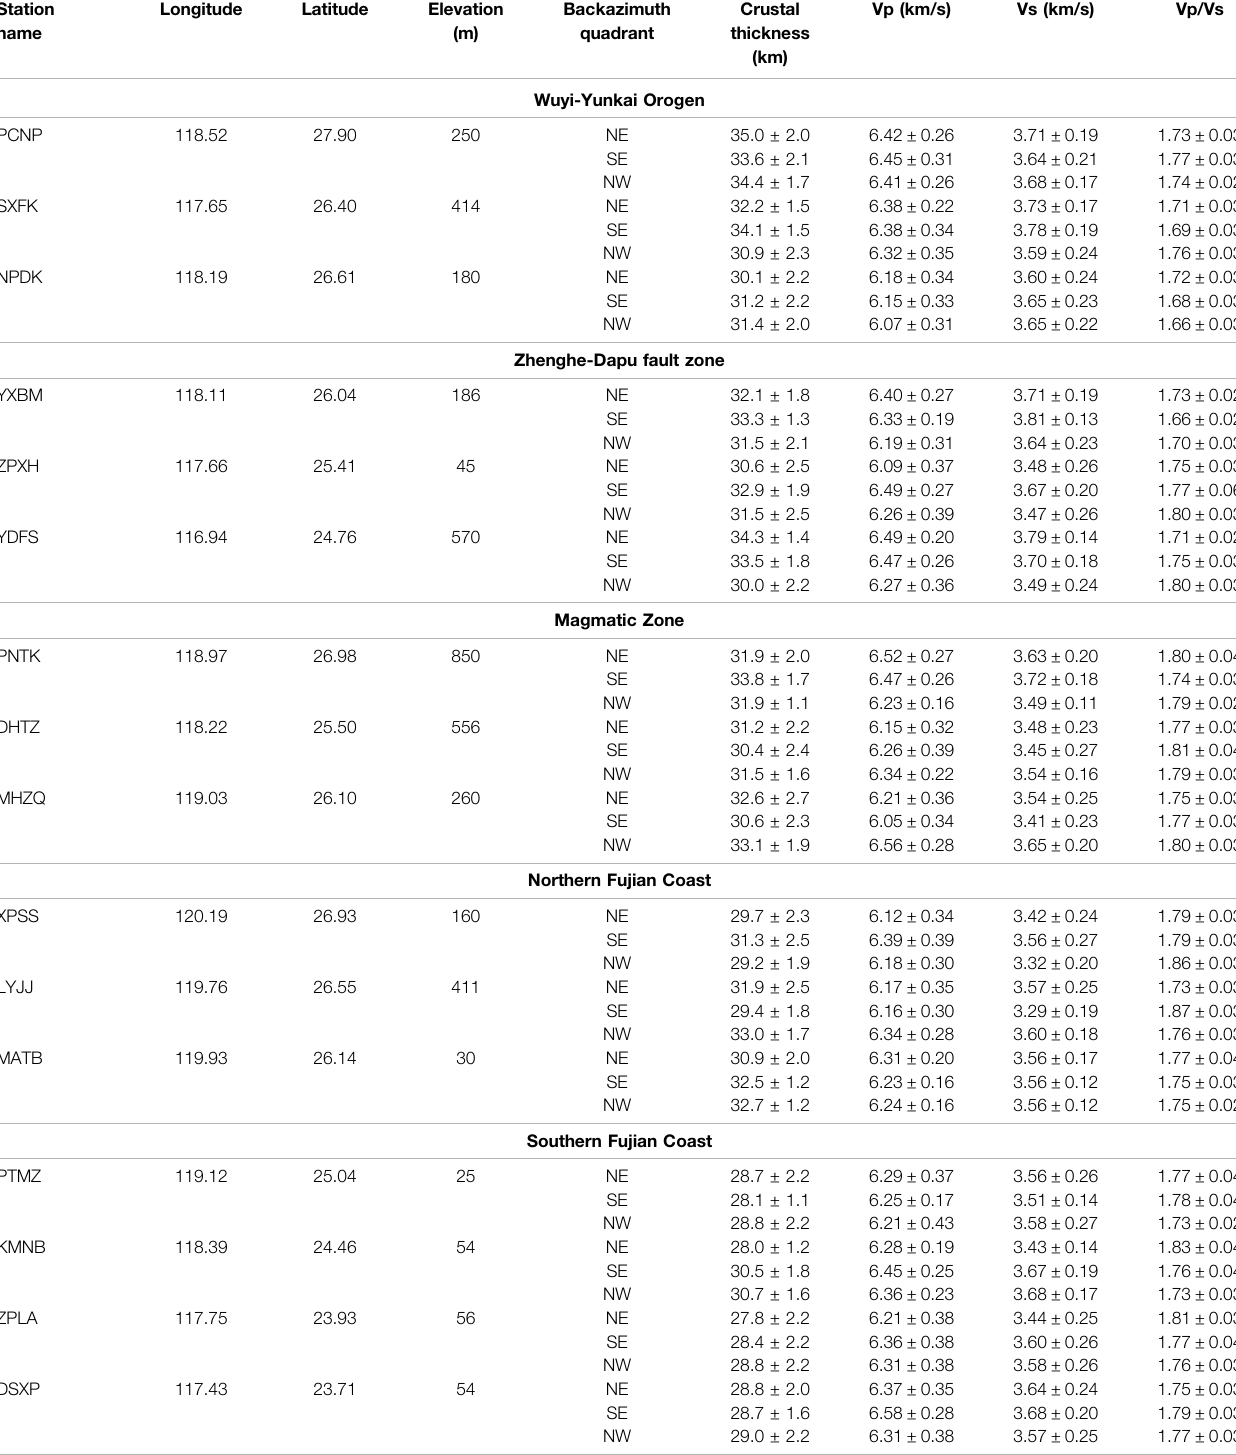
TABLE 1 | Summary of crustal thickness (H) and average P- and S-wave velocity (Vp and Vs) of the crust including their estimated uncertainties resulting from the H-V stacking for all the three backazimuth sectors at 17 broadband stations. Station